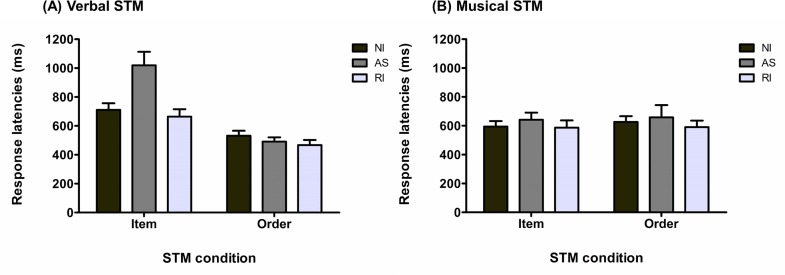
Response latencies for Experiment 1.(A) Response latencies (mean and standard error) for the vSTM task as a function of STM task and interference conditions (NI: no-interference; AS: articulatory suppression; RI: rhythmic interference). (B) Response latencies (mean and standard error) for the mSTM task as a function of STM task and interference conditions (NI: no-interference; AS: articulatory suppression; RI: rhythmic interference).